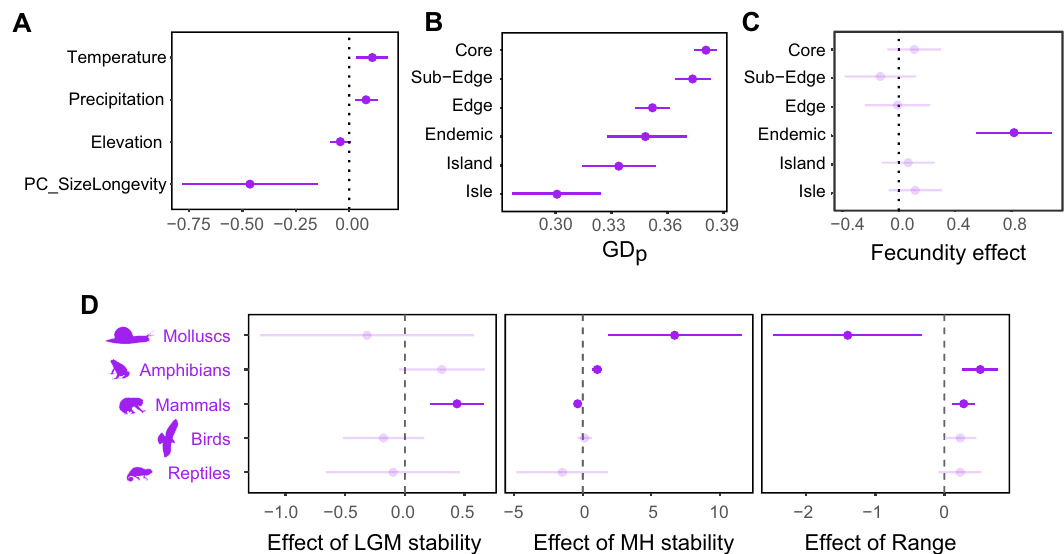
Fig. 4 Effects of fi xed variables on animal GD P . The panels represent 95% con fi dence intervals with mean phylum-independent effects of temperature, precipitation, elevation and body size/longevity ( A ), biogeographic position ( B ), position-dependent effects of fecundity ( C ) and phylum-dependent effects of temperature stability and species ’ range ( D ), as derived from the animal kingdom model (Supplementary Data 6). Non-signi fi cant effects (p-values > 0.05) are transparent. Source data are provided as a Source Data fi le.